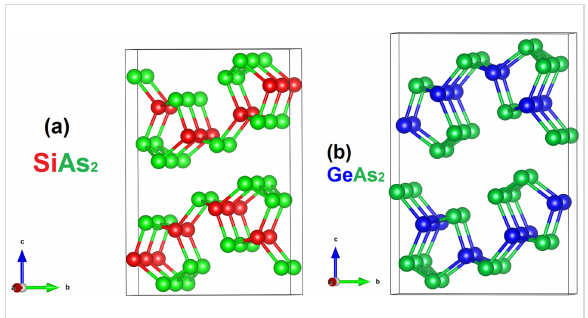
Figure 1: Crystal structure side view of (a) SiAs 2 bulk (3 × 2 super cells) and (b) GeAs 2 bulk (red: silicon, blue: germanium, green: